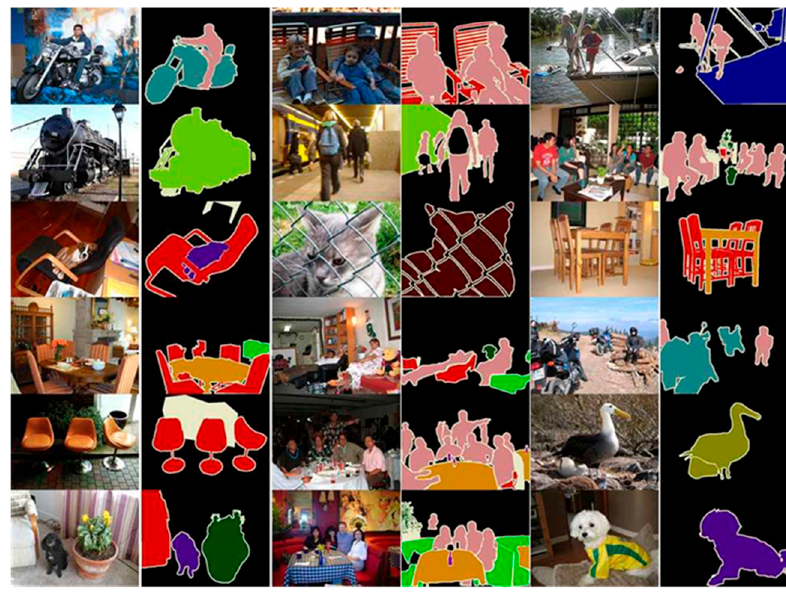
Figure 19. Result of the proposed method for the PASCAL VOC 2012 database photos.